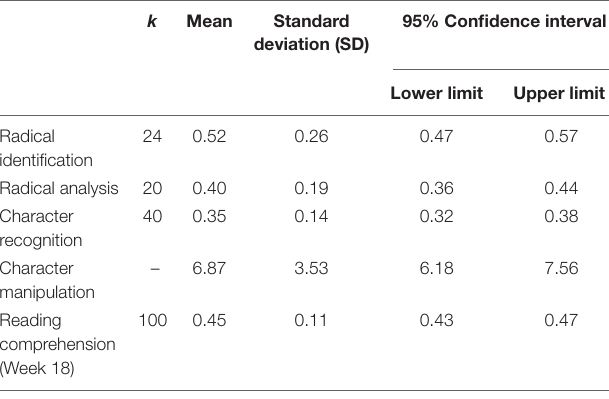
TABLE 2 | Descriptive statistics of radical identification, radical analysis, character recognition, character manipulation, and reading comprehension ( N = 103).